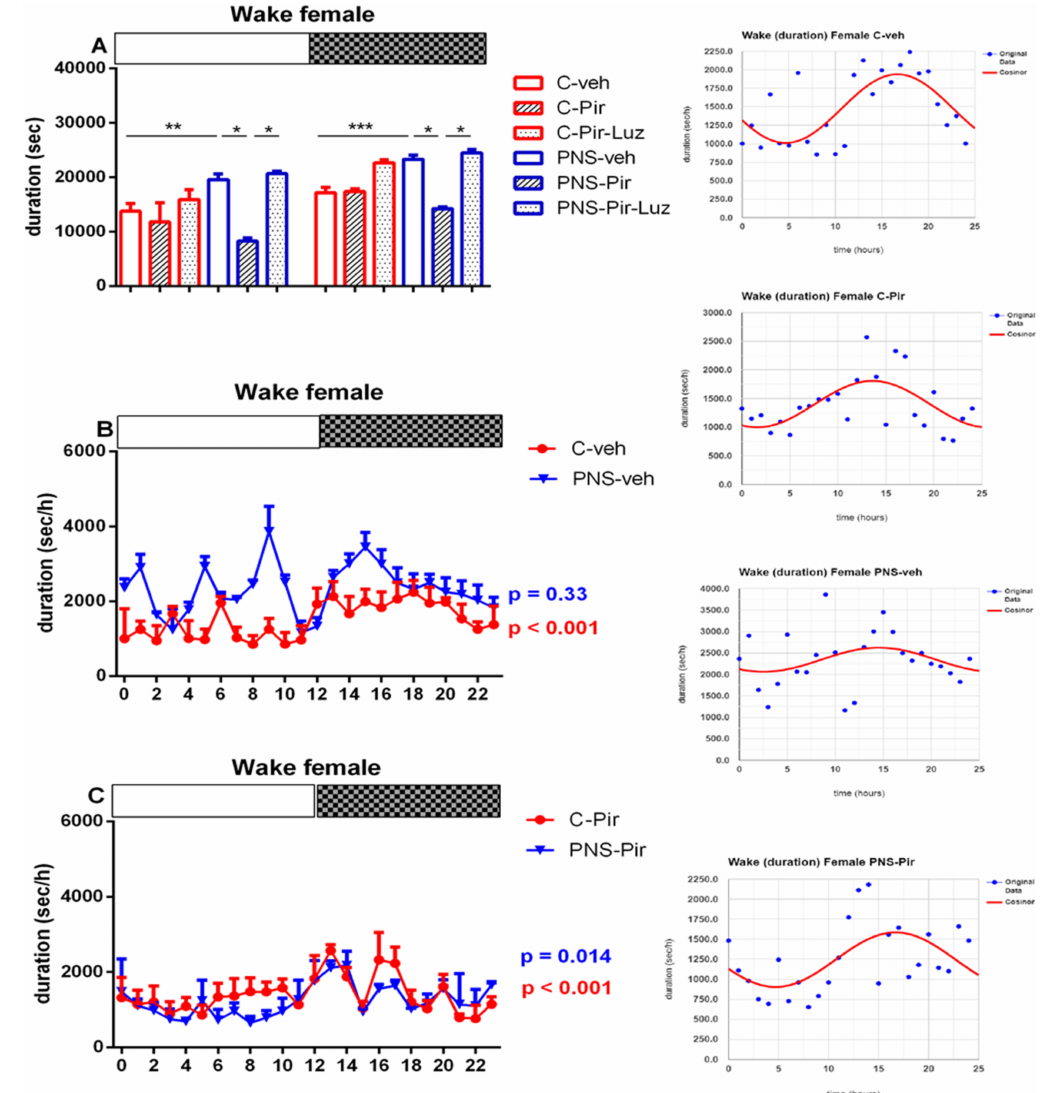
Figure 5. Diurnal wake rhythm (duration, sec/h) in female rats during the Light and the Dark phase, indicated by open and black rectangles above the figure, over a 24-h recording for C-veh, C-Pir, C-Pir-Luz, PNS-veh, PNS-Pir and PNS-Pir-Luz group ( A ). Circadian distribution of Wake events (duration, sec/h) for C-veh and PNS-veh groups ( B ) and C-Pir and PNS-Pir groups ( C ) over a 24-h recording. Original and cosinor data are shown in inset on the right. * p < 0.05, ** p < 0.01, *** p < 0.001 vs. C-veh, PNS-veh or PNs-Pir group, respectively. of the Nrem Pattern during the Light and the Dark Phase in Male and Female Rats via the Melatonin (Mt)